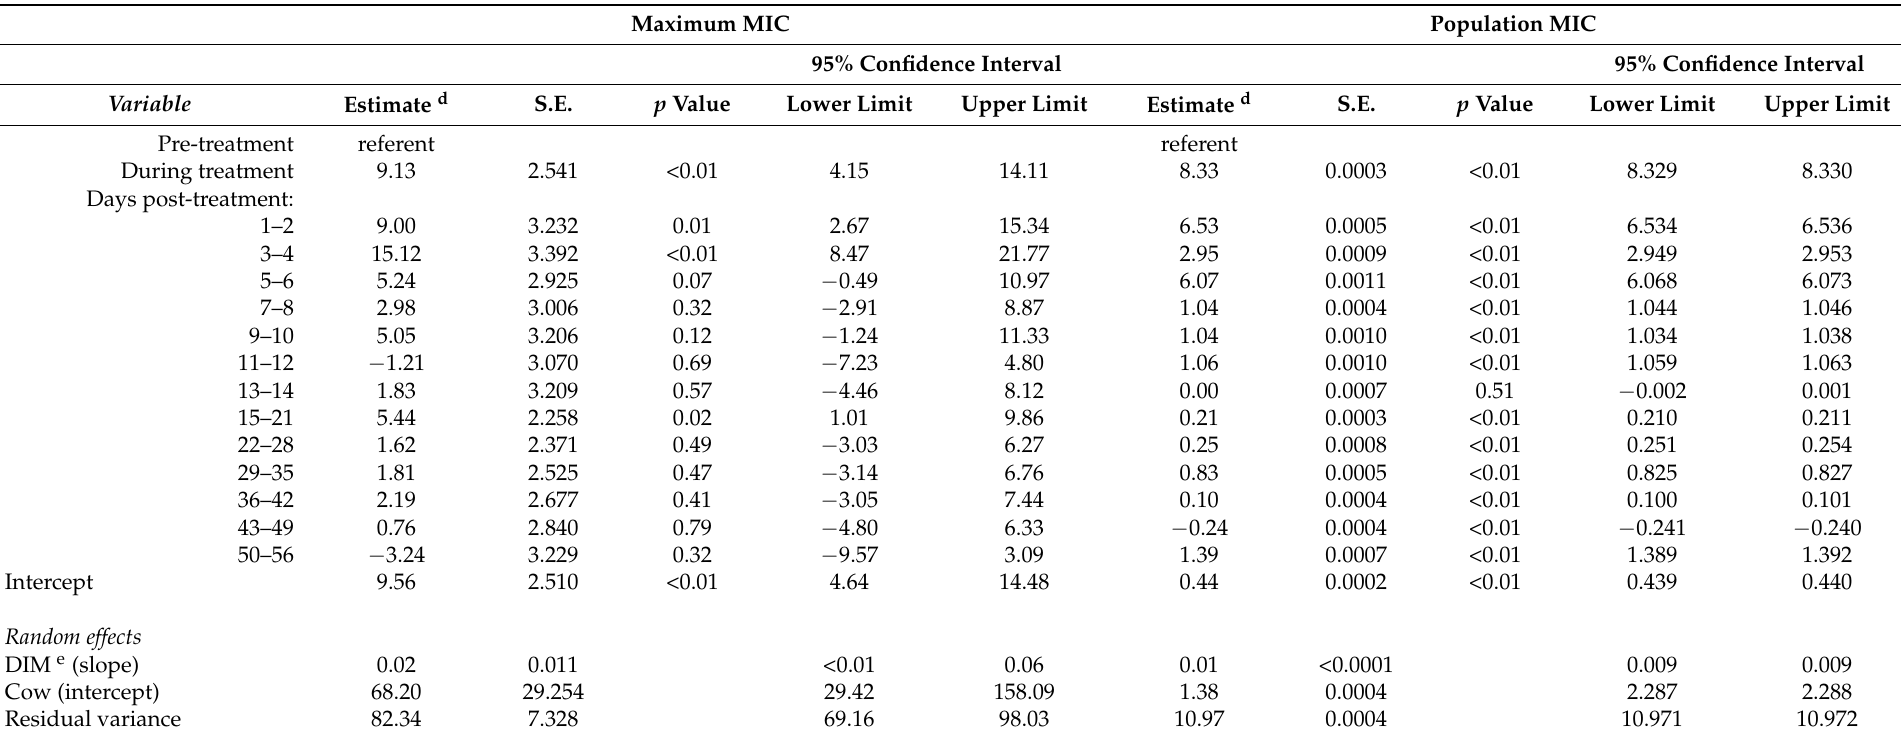
Table 6. Multilevel mixed effect interval regression output for the Maximum a and Population b ceftiofur MIC c models for Enterobacteriaceae, post-systemic antimicrobial drug treatments in 16 cows on a California dairy over two